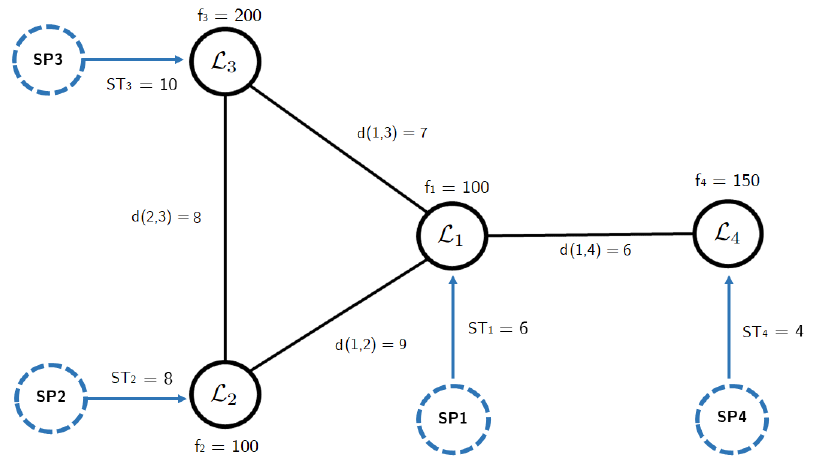
Figure 5. Example: local optima network and measures. The fitness levels of the local optima are f L = ( 50, 100, 200, 150 ) , representing the node weights; and the respective edges have weights d = ( 9, 7, 6, 8 ) determined by the relocate distance between the corresponding local optima, as shown in Figure 5. Moreover, the median fitness value of twenty runs computed with Simulated Annealing is f SA =